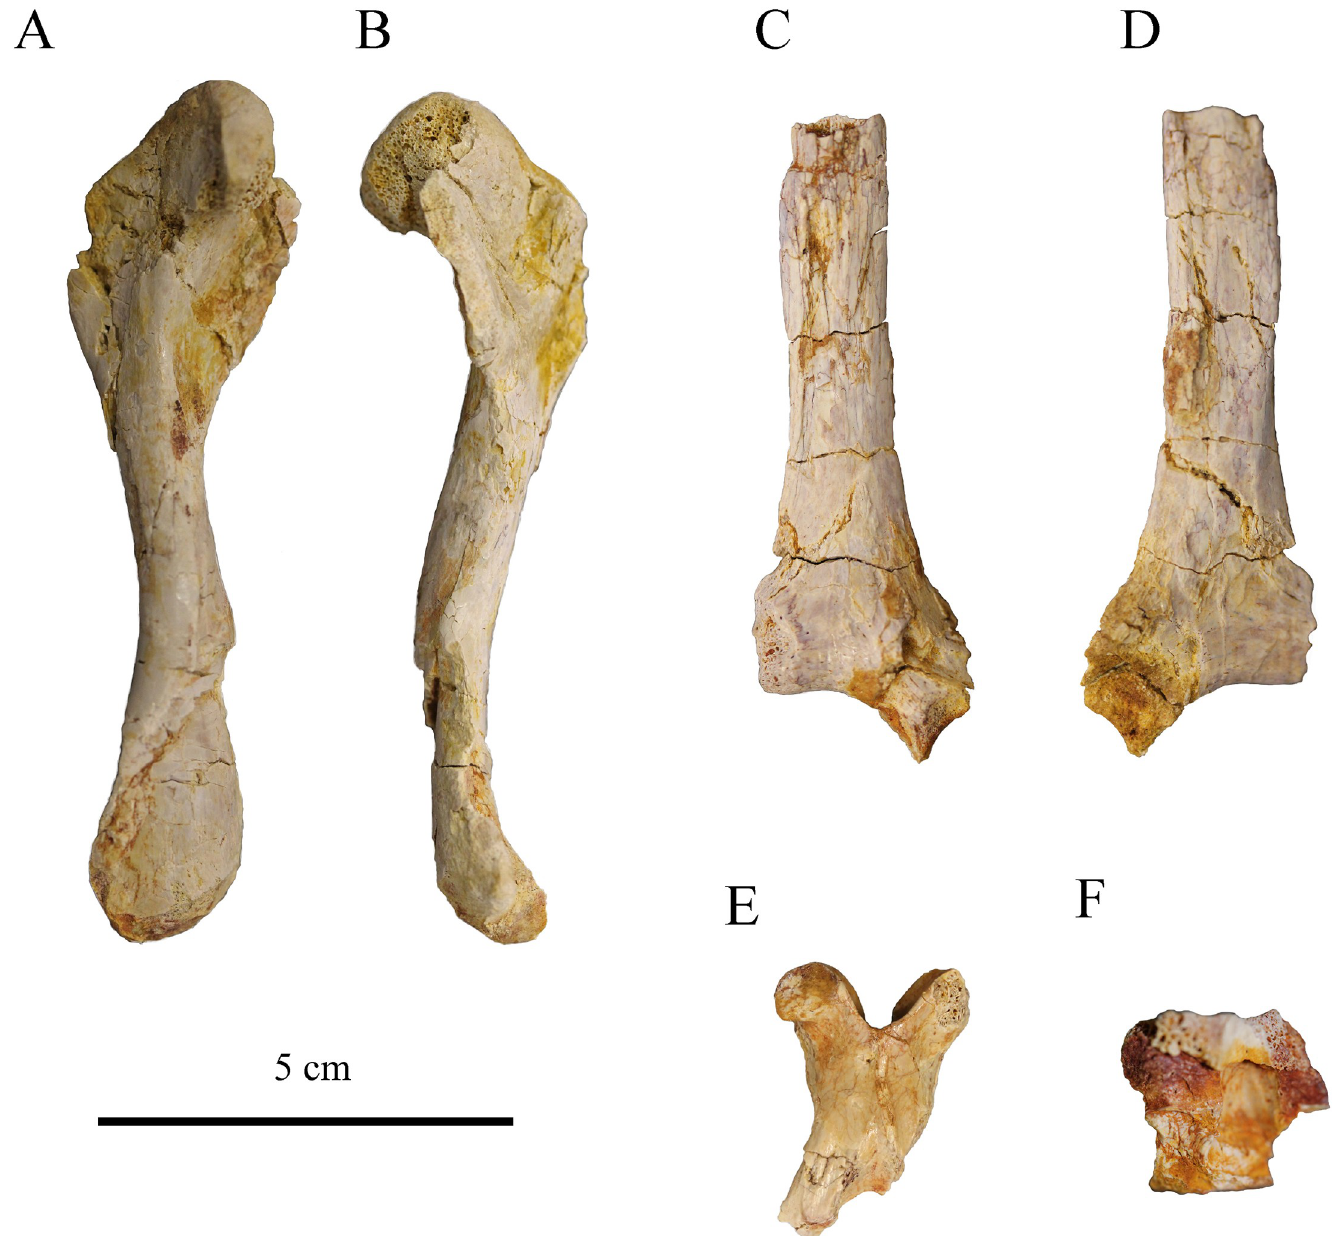
Fig 8. Postcranial material MJSN CBE-0001. Left femur in dorsal (A) and posterior (B) views; scapula in medial (C) and lateral (D) views; cervical vertebra in dorsal view (E); caudal vertebra in ventral view (F).